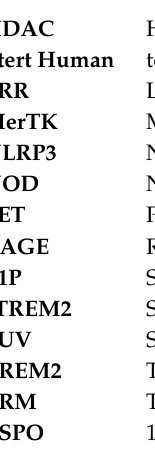
Figure 3. Sphingosine 1 phosphate receptor ligands.